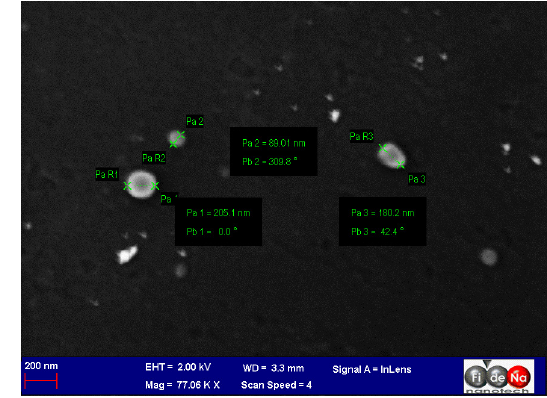
Figure 1. SEM micrograph of PLGA-Mag nanospheres.